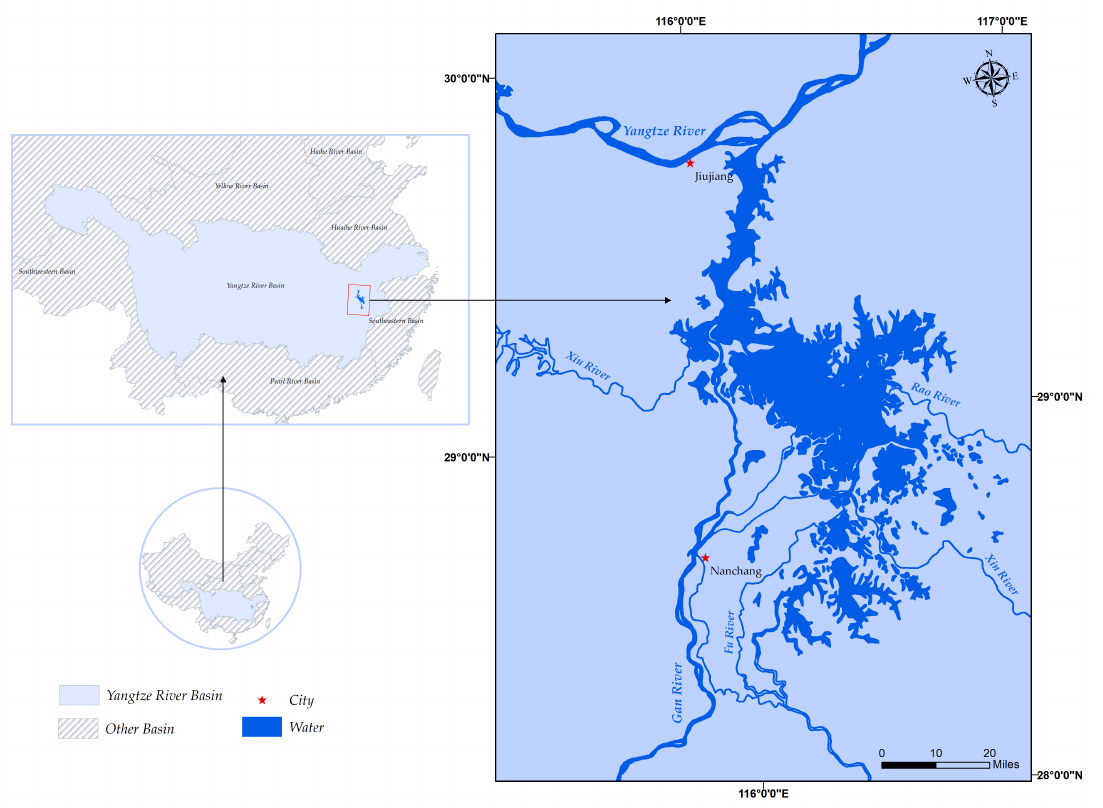
Figure 1. Location of Poyang lake within the Yangtze River Basin ( left ) and at an average level ( right